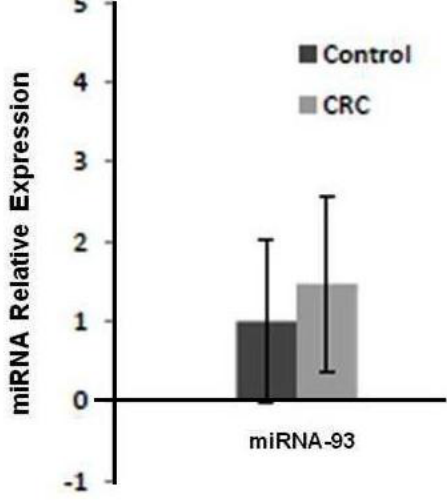
Fig. 3. The expression level of miRNA-409 in plasma of colorectal cancer patients: Real-time RT- PCR was applied to assess the plasma level of miRNA-409 in CRC patients. miRNA-409 was significantly increased by 2.4 fold in CRC patients relative to the normal group (p<0.05).